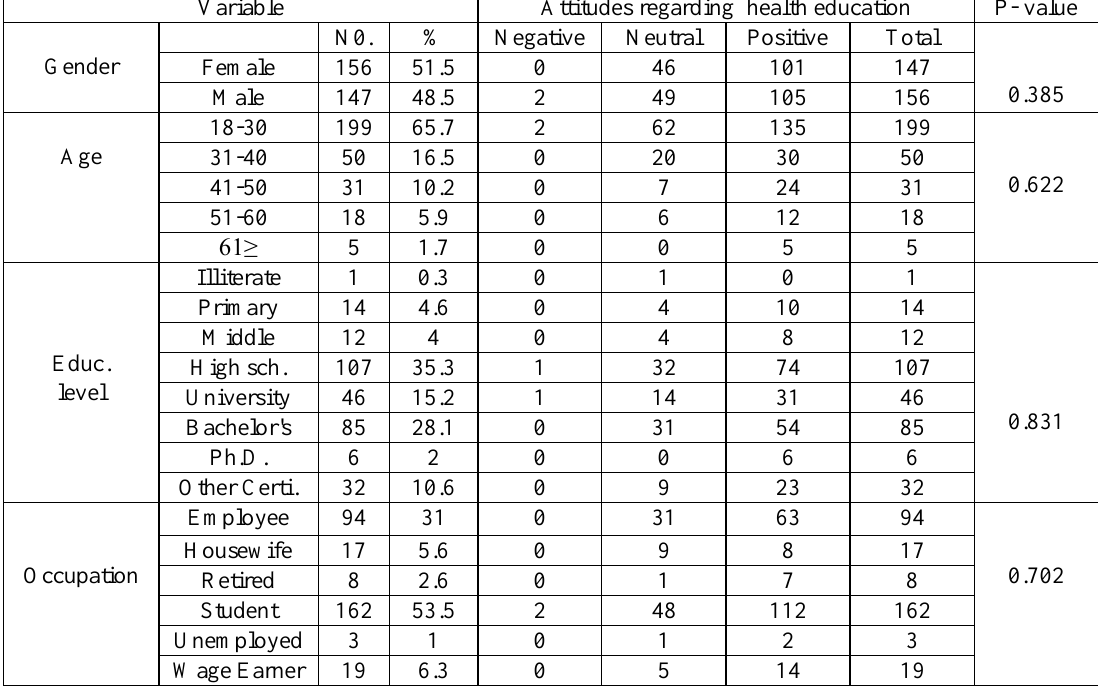
Table (2): Association between attitude regarding health education & Gender, Age, Educational level, Occupation of